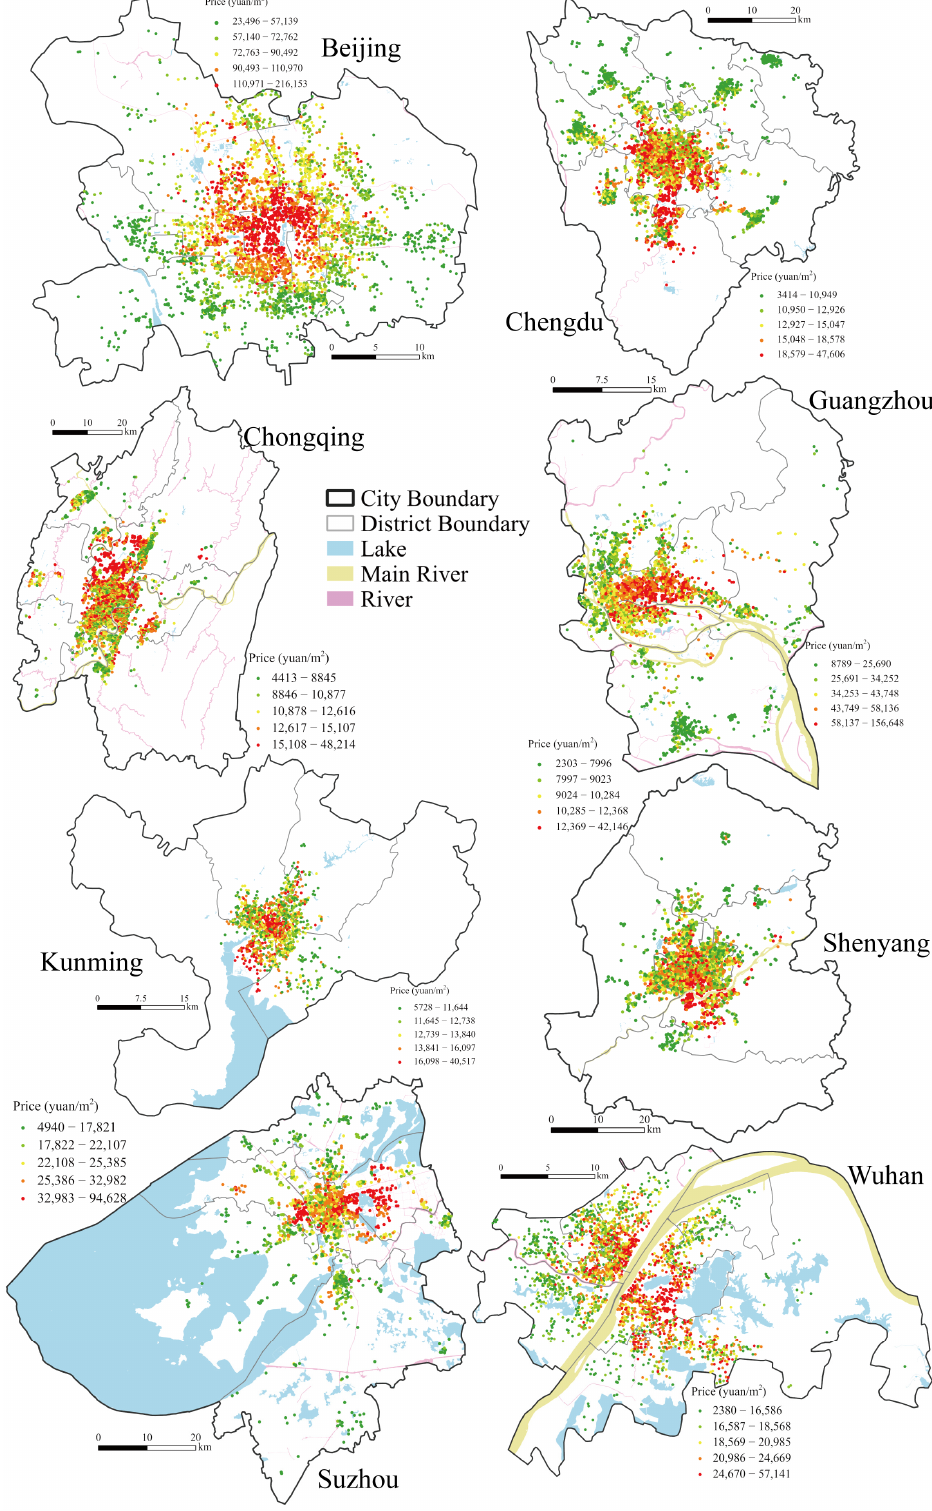
Figure 3. General methodological flow. Distribution of urban blue spaces (UBS) and community data in study cities. (The quintiles grading was used to grade the house prices in cities).